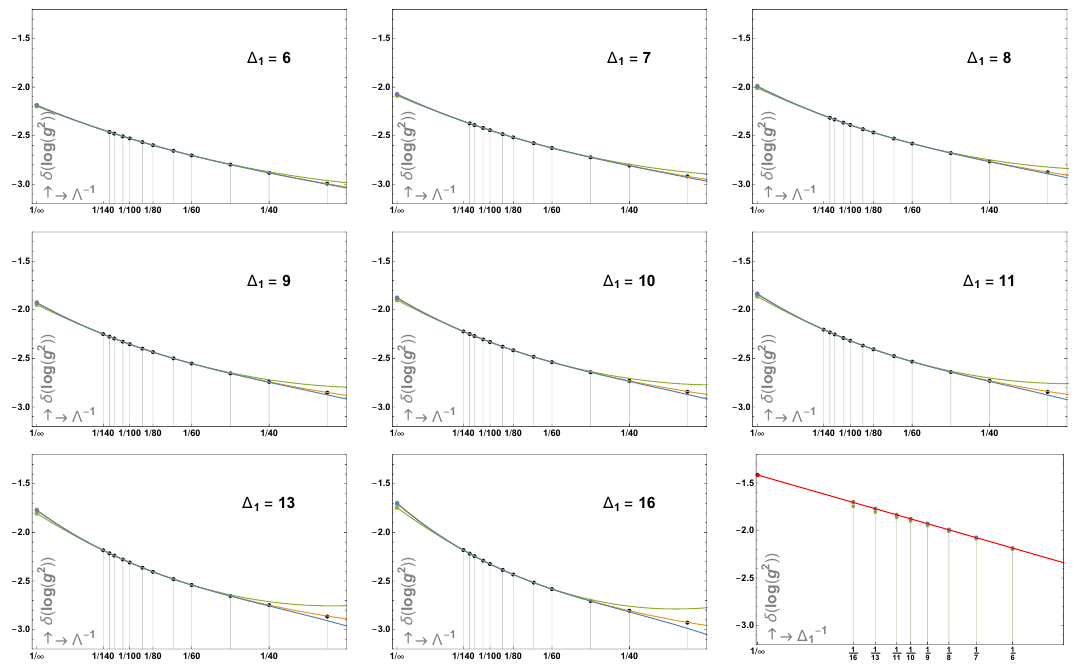
Figure 26. The double extrapolation for the data point with m 2 =m 1 = 1 : 15 in (cid:12)gure 12. Vertically we plot the logarithm of the maximal coupling, but with the logarithm of the single-correlator bound subtracted, so (cid:14) (log( g 2 )) = log( g 2 ) log( g 2 ). In the (cid:12)rst 8 plots we show our raw max max,multi max,single (cid:0) data in black, and the curves correspond to three di(cid:11)erent extrapolations to in(cid:12)nite (cid:3). In the (cid:12)nal plot we collected the (cid:3) extrapolations and the single red line represents our (cid:1) 1 ! 1 extrapolation. Our (cid:12)nal answer gives (cid:14) (log( g 2 )) 1 : 446 in the (cid:13)at-space limit, and adding the max (cid:25) (cid:0) single-correlator bound 3 : 673 gives the 2 : 226 plotted in (cid:12)gure